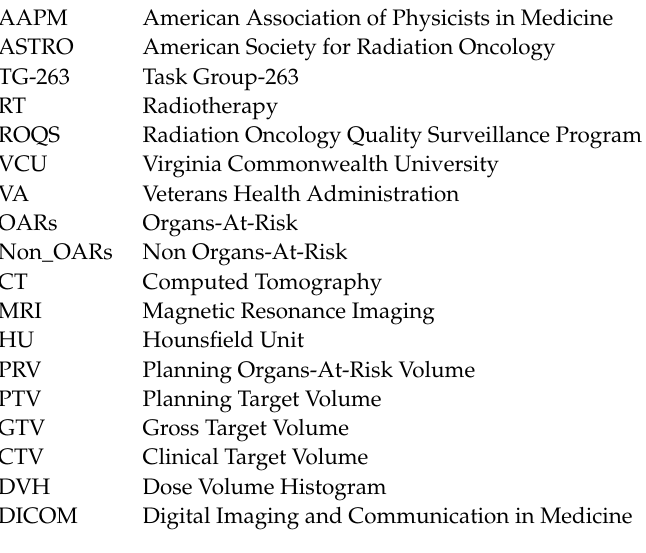
arate, with 100 image features; Table S17: Intermediate integration label-wise results—VA-ROQS dataset lung, BonesSeparate, 50 image features, 200 text features, with random forest algorithm; Table S18: Intermediate integration label-wise results—VCU dataset Lung, BonesSeparate, 50 im- age features, 200 text features, with random forest algorithm; Table S19: Intermediate integration label-wise results—VA-ROQS dataset prostate, BonesSeparate, 50 image features, 200 text features, with random forest algorithm; Table S20: Intermediate integration label-wise results—VCU dataset prostate, BonesSeparate, 50 image features, 200 text features, with random forest algorithm; Table S21: Table S22: Late integration label-wise results—VCU dataset lung, BonesSeparate, 100 image features, 200 text features; Table S23: Late integration label-wise results—VA-ROQS dataset prostate, BonesSep- arate, 100 image features, 200 text features; Table S24:Late integration label-wise results—VCU dataset prostate, BonesSeparate, 100 image features, 200 text